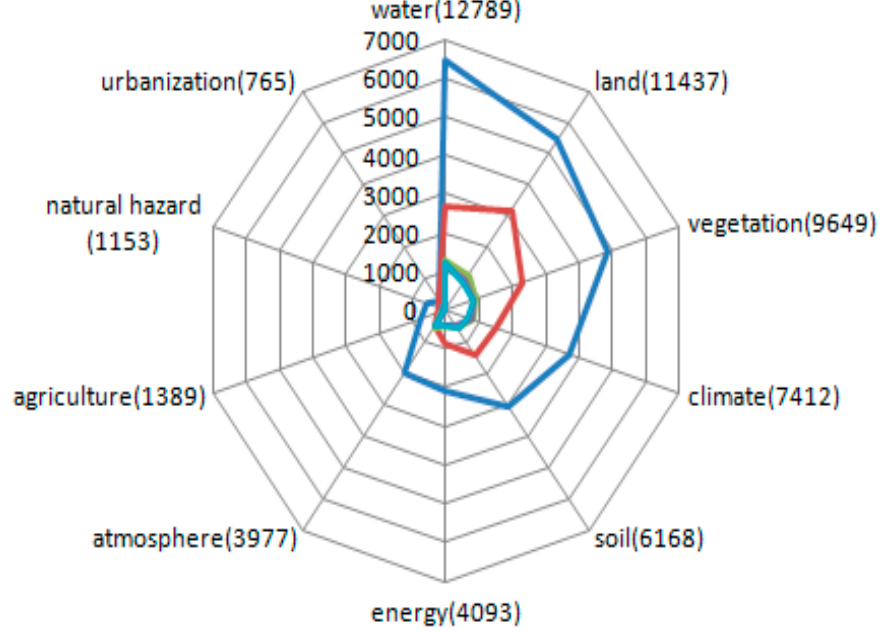
( C ′ ) Annotation: The blue line represents the United States, the red line represents China, the green line represents Germany, the purple line represents Britain, and the cyan line represents France. Figure 5. Distributions of remote-sensing-related publications for the 1999–2021 period. Distributions of remote sensing: ( A ) technology; ( B ) methodology; ( C ) applications in different stages; distributions of remote sensing: ( A’ ) technology; ( B’ ) methodology; ( C’ ) applications in top productive countries. The top seven clusters relative to stages and countries are further identified in Figure